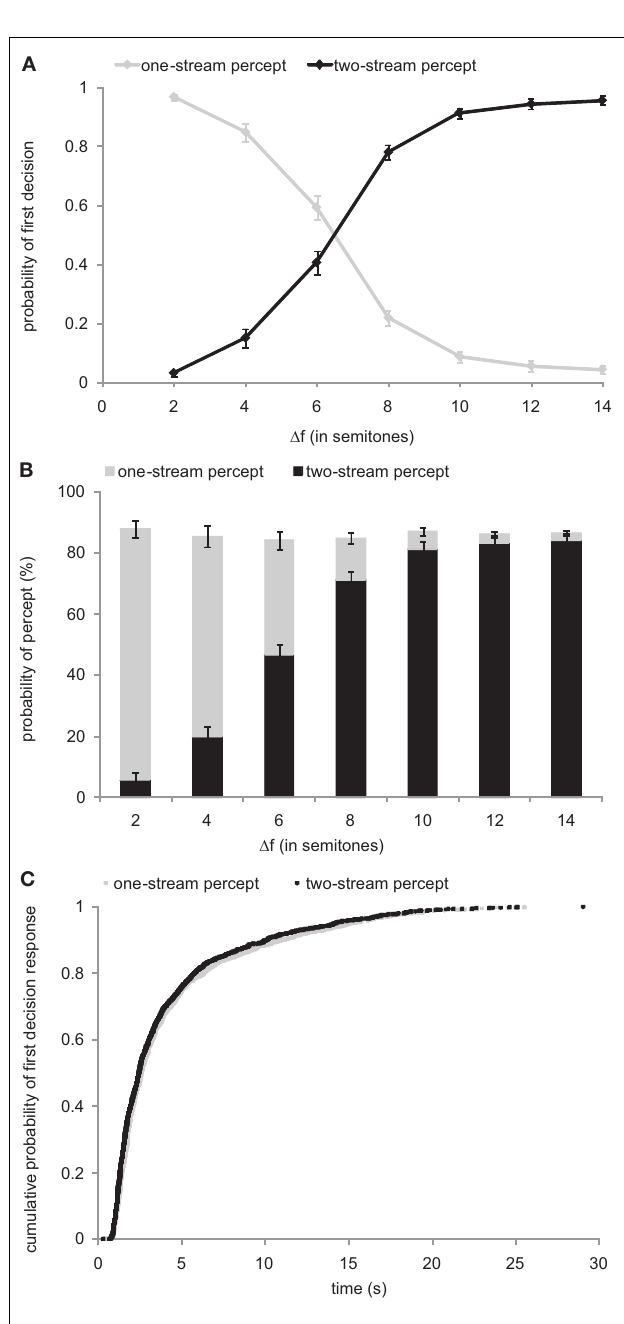
FIGURE 2 |Absence of a default one-stream percept. The functions in (A) show the probability that the first decision is that of a one-stream percept (gray line) or that of a two-stream percept (black line), plotted as a function of ∆ f . Symbols and error bars represent mean and SEM. (B) Proportions of time that the stimulus sequence was perceived as two streams (black bars) and as one stream (gray bars). Data were pooled over the first and second measurement. Note that the summed proportions do not add up to 1.This “missing” proportion represents the time from stimulus onset until the first perceptual decision was reported. (C) Cumulative distributions of latencies to the first perceptual decision, separated according to the decision (one-stream percept, N = 1234 or two-stream percept, N = 1833).The distributions were derived by combining latencies across all subjects and